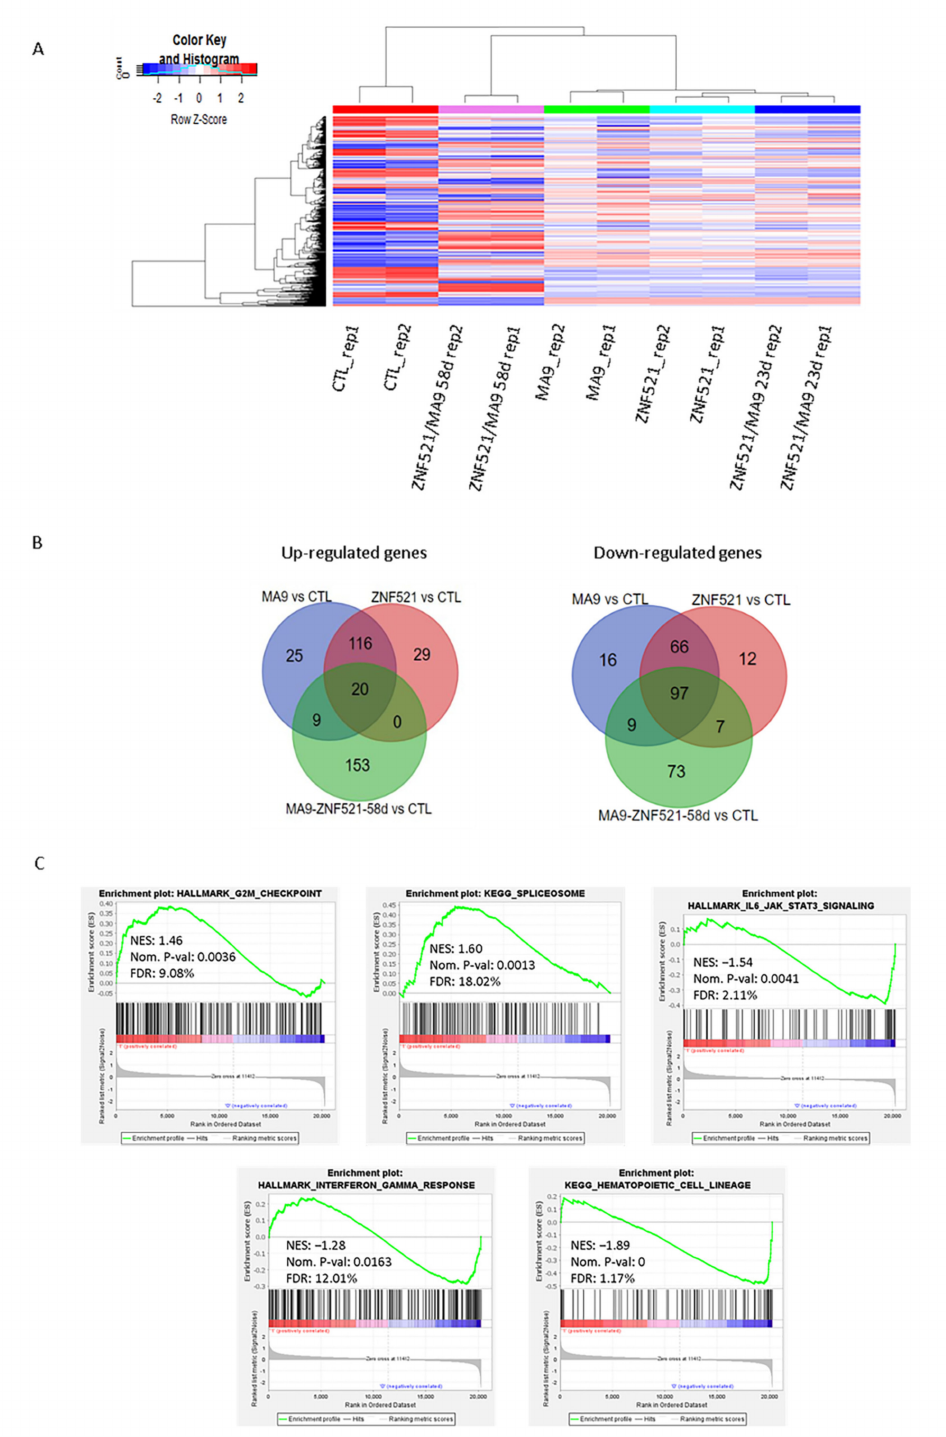
Figure 3. Gene expression analysis was performed with the ClariomD array. ( A ) Clustering on the top 1% (1358/135750) of transcripts with the highest variance across the entire dataset. Average clustering method was applied. Blue–red color scale was used to set rows with a mean of zero and a standard deviation of one. ( B ) Venn diagrams illustrating the significantly up- or down-regulated genes at FDR <10% by RankProduct analysis in ZNF521 and MA9 at 23 days or after their combination at 58 days compared to control cells. The corresponding transcript lists are reported in Supplementary File S2. ( C ) Selected significant Hallmark and Kegg pathways determined by GSEA analysis with corresponding normalized enrichment score (NES) and p -value